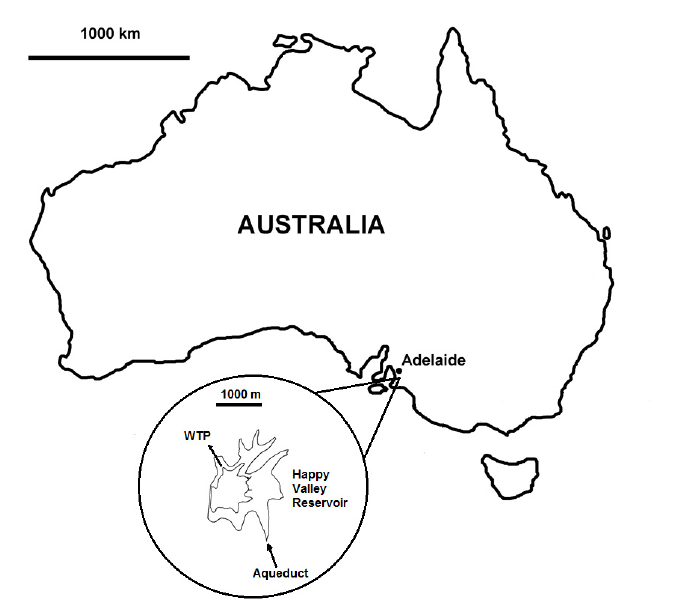
Figure 1. Location of Happy Valley Reservoir. Inset shows 10 m contours of depth and inflow from the aqueduct and the location of the offtake to the water treatment plant